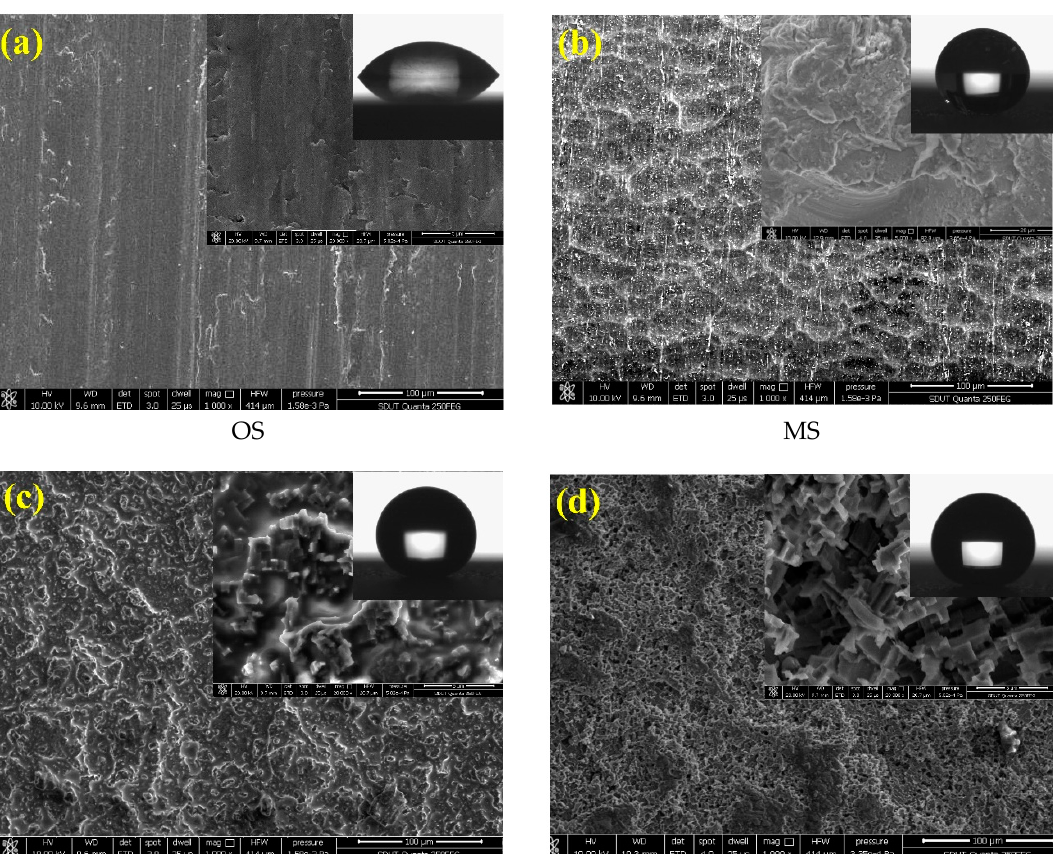
Figure 3. Surface morphologies of aluminum alloy samples. ( a ) Original microstructure before sand peening (SP) and electrochemical oxidation (ECO); ( b ) microscale pits structure generated by SP; ( c ) nanoscale corals structure formed by ECO; ( d ) micro-nanoscale binary structure fabricated by SP and ECO. Table 4. Surface roughness and wettability of the aluminum alloy sample with original sample